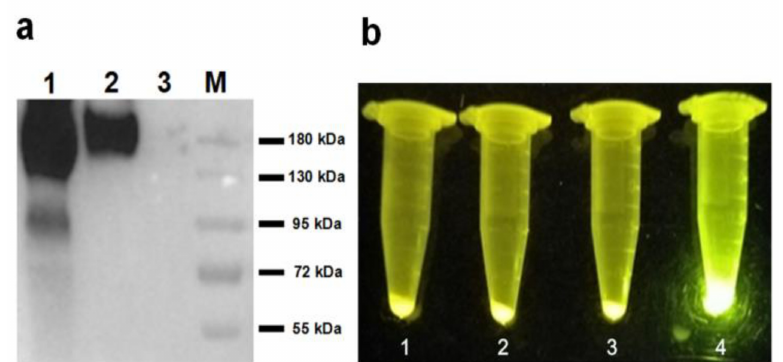
Figure 6. ( a ) The western-blot analysis indicated that the HA-Im7-SED1 and HA-SED1 fusion proteins were displayed on the surface of P. pastoris cells. ( b ) The blue light transmitter analysis showed that CL7-sfGFP proteins were indirectly immobilized on the surface of P. pastoris